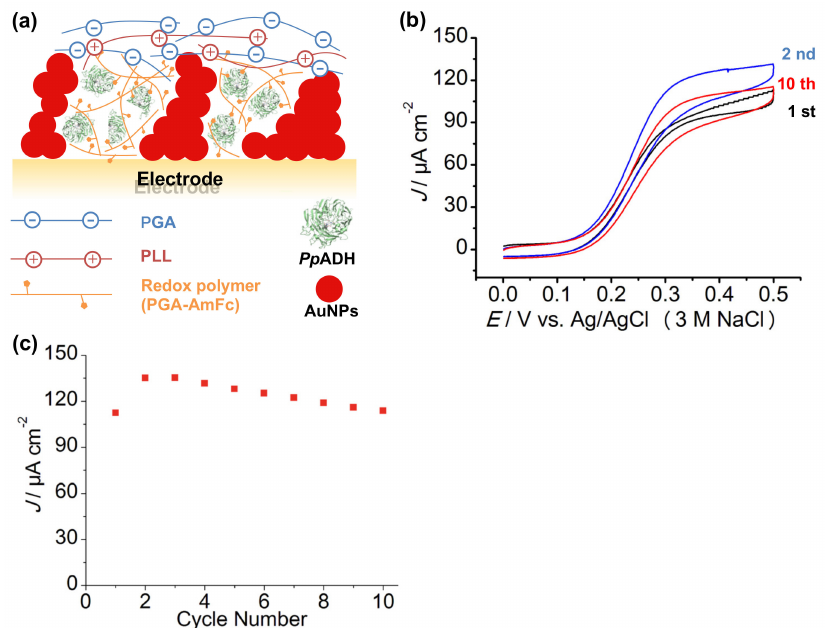
Figure 8. ( a ) Schematic illustration of the Pp ADH-modified AuNPsE with the polyion complex and PGA-AmFc. ( b ) Cyclic voltammograms of the Pp ADH and PGA-AmFc-modified AuNPsE at 1st scan (black), 2nd scan (blue), and 10th scan (red) in 50 mM CHES (pH = 9.0) containing 30 mM ethylamine and 100 mM ethanol. The voltammograms were obtained at a scan rate of 10 mV · s − 1 . ( c ) Catalytic current densities of AuNPsE at 0.5 V vs. Ag/AgCl dependence on cycle